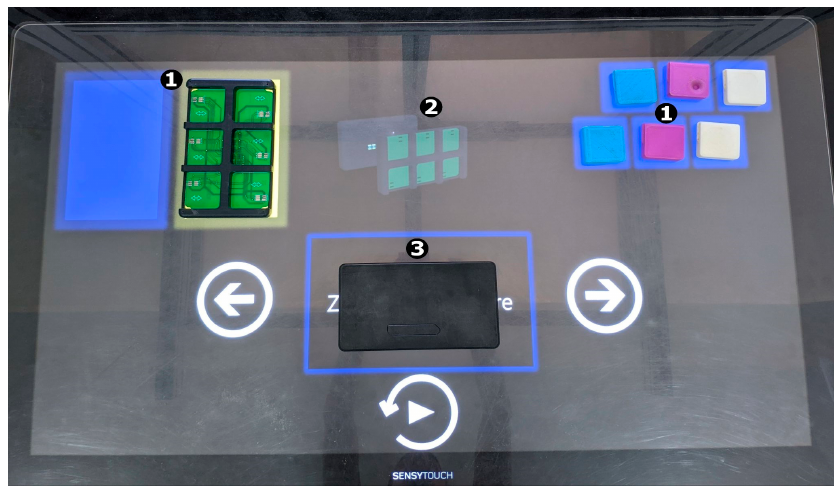
Figure 2. The graphical interface of the manual assembly assistance system. 1: parts storage area; 2: video and audio instructions; 3: workspace area.